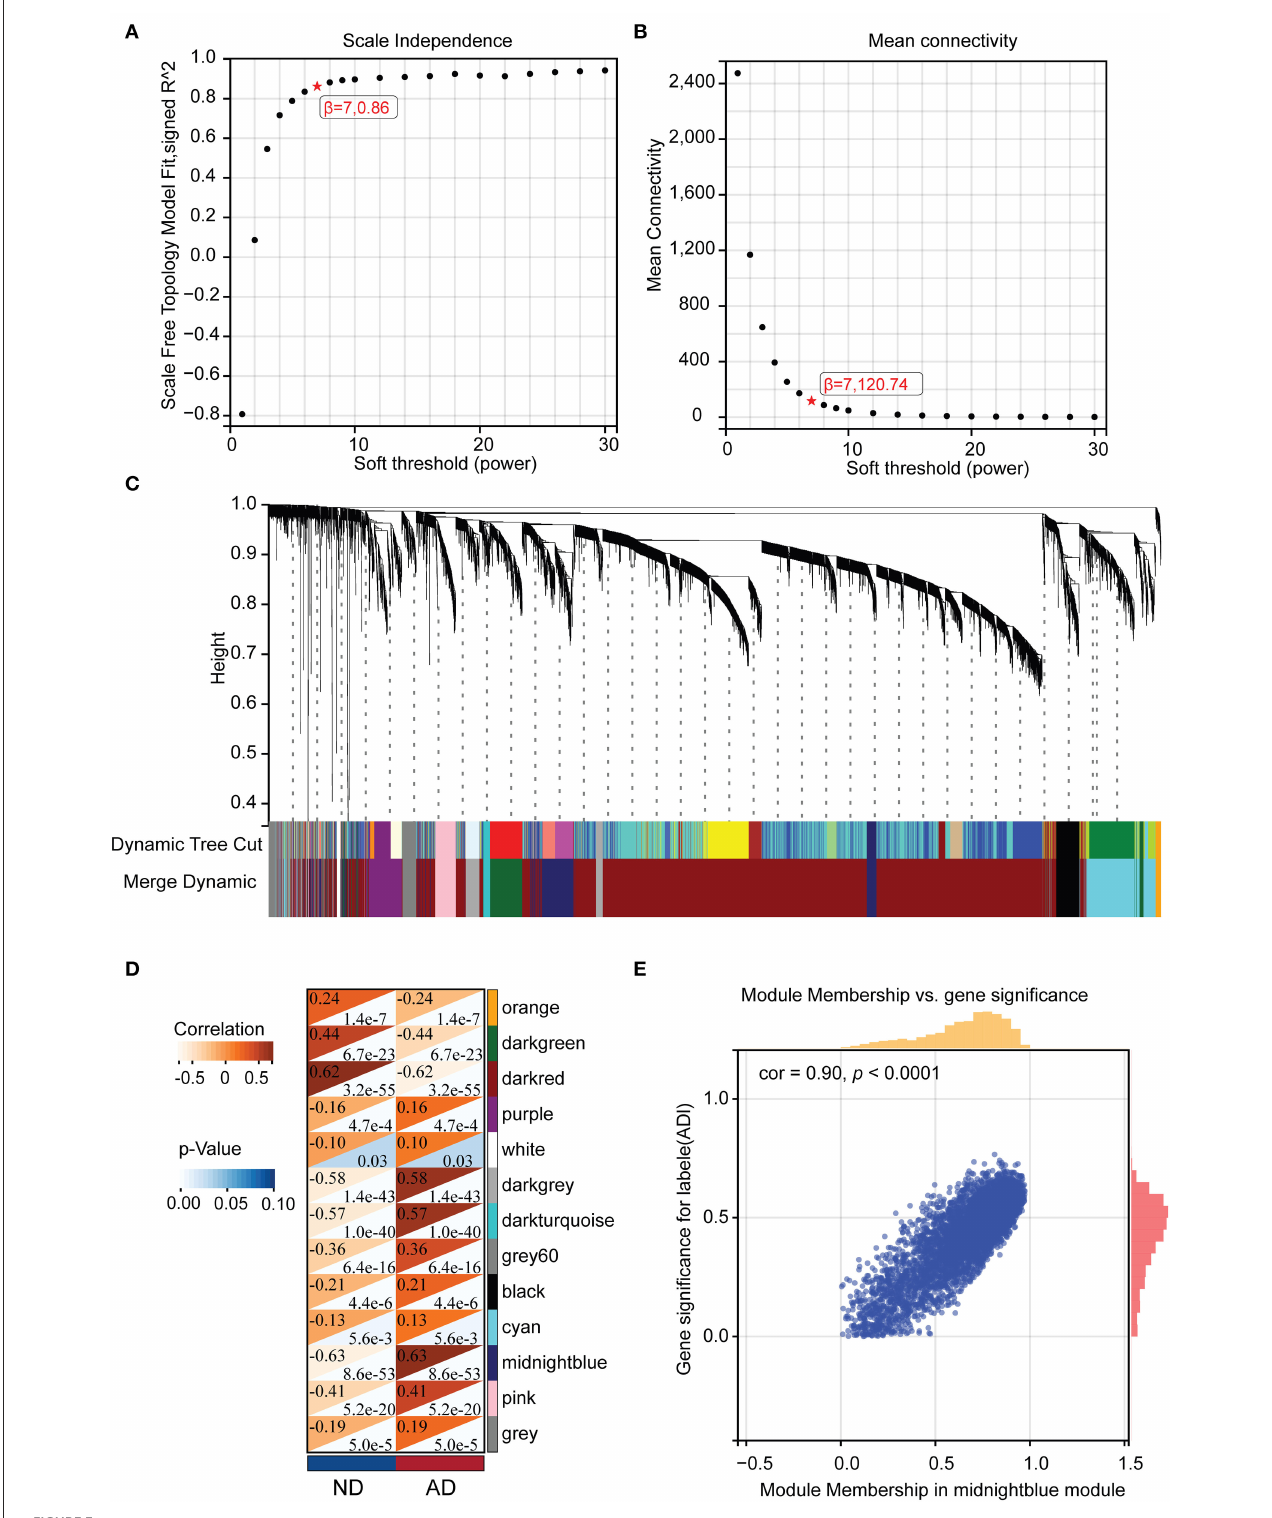
FIGURE3 The WGCNA results. (A) Analysis of the scale-free fit index for various soft-thresholding powers ( β ). (B) The mean connectivity for the soft-thresholding powers. (C) Clustering dendrograms of genes, with dissimilarity based on the topological overlap, together with assigned module colors. (D) Correlations between different modules and clinical traits. (E) Correlation of module membership and gene significance in the midnight blue